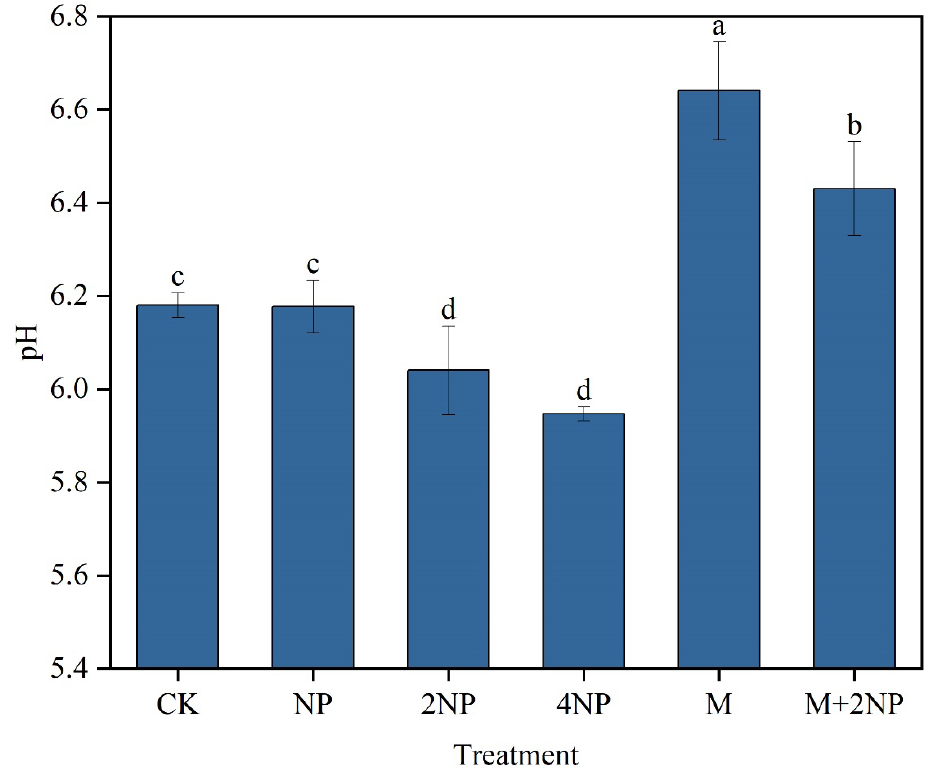
Figure 2. Changes of soil pH in different fertilization treatments. Different lowercase letters indicate significant differences among treatments ( p < 0.05). Abbreviations: CK = no fertilizer; NP = low−dose chemical fertilizer; 2NP = moderate−dose chemical fertilizer; 4NP = high−dose chemical fertilizer; M = normal−dose organic fertilizer; M+2NP = normal−dose organic fertilizer + moderate−dose chemical fertilizer.